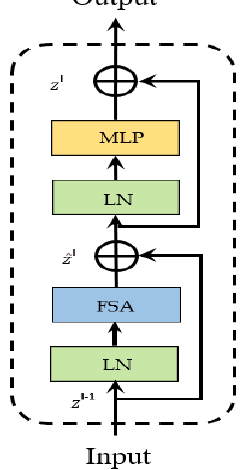
Figure 3. The feature extraction backbone network.